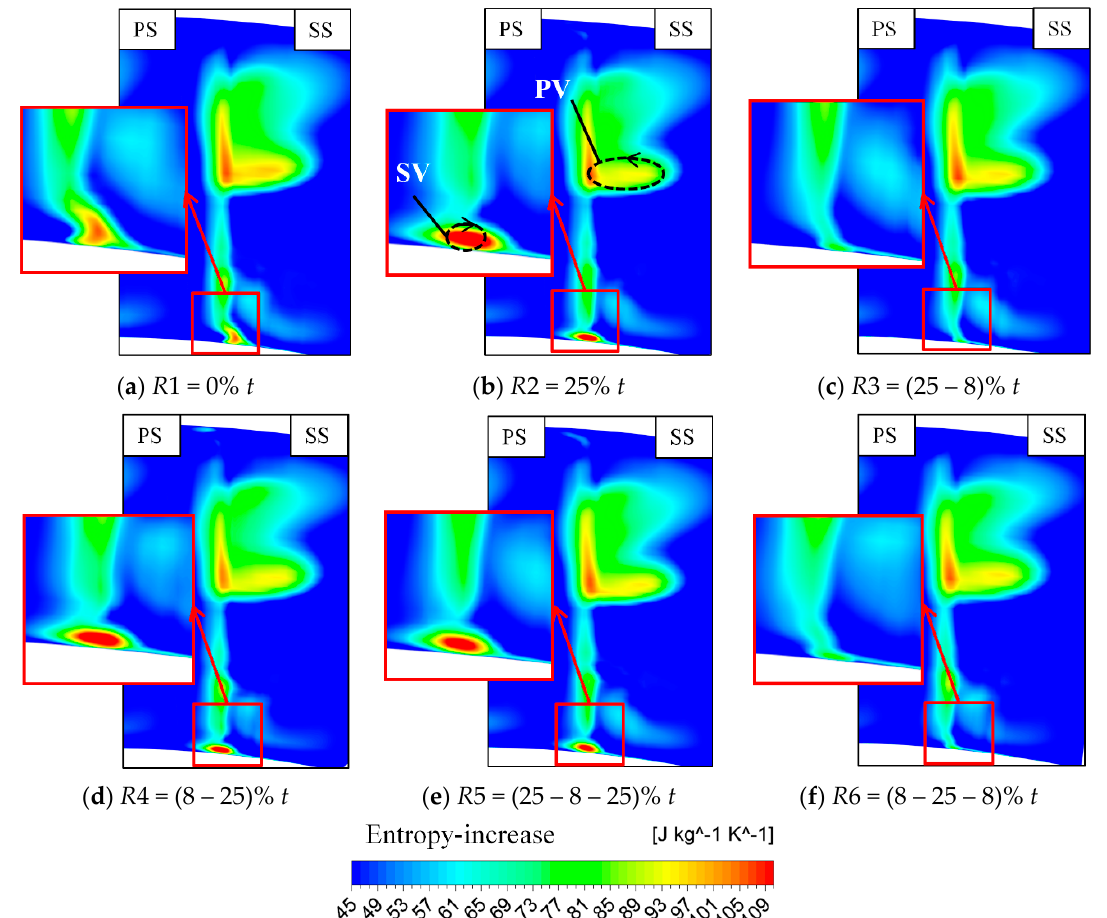
Figure 12. Entropy-increase isoline at 110% axial chord length of S2.